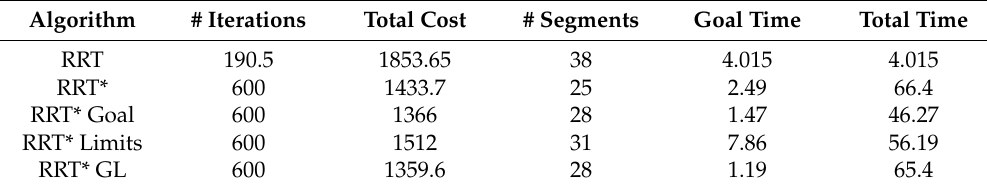
Table 8. Results. Two obstacles, 600 iterations.